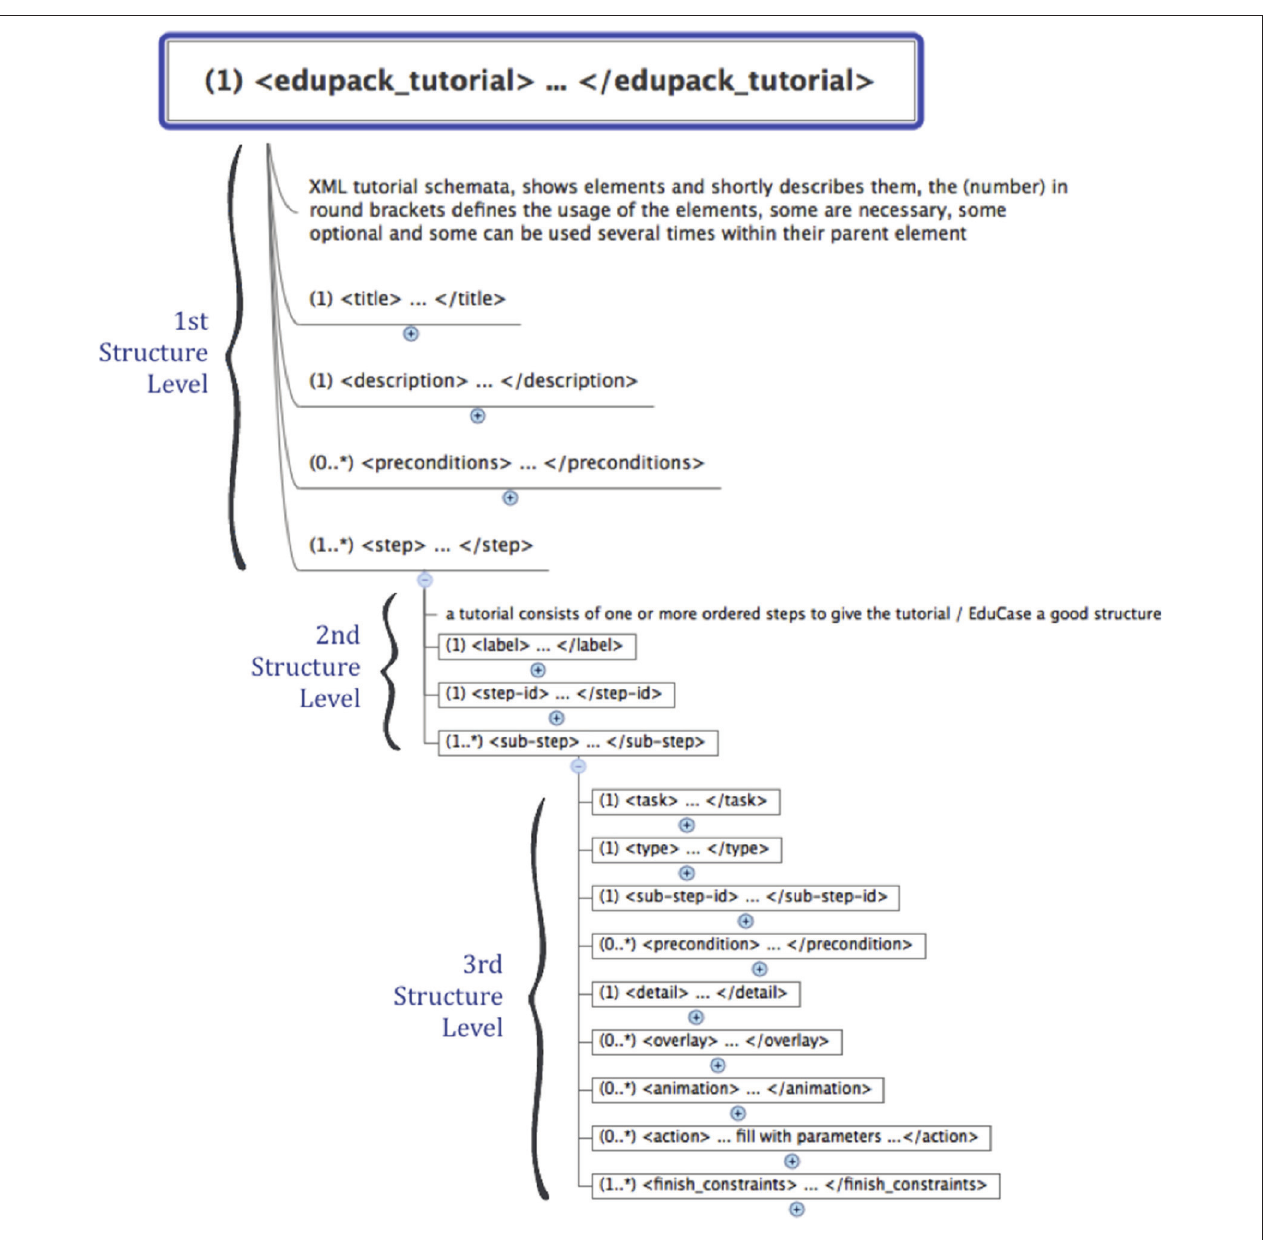
FIGURE 7 | Overview of the XML Tutorial structure of all three